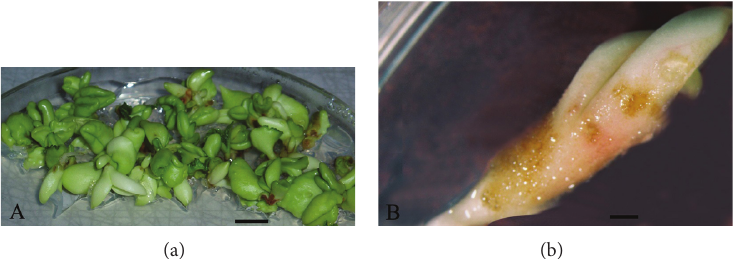
Figure 1: Androgenic embryos in cotyledonary stage of Aesculus hippocastanum (a) and Aesculus flava (b) cultivated on MS hormone-free medium. Scale bar: (a) 10 mm; (b)